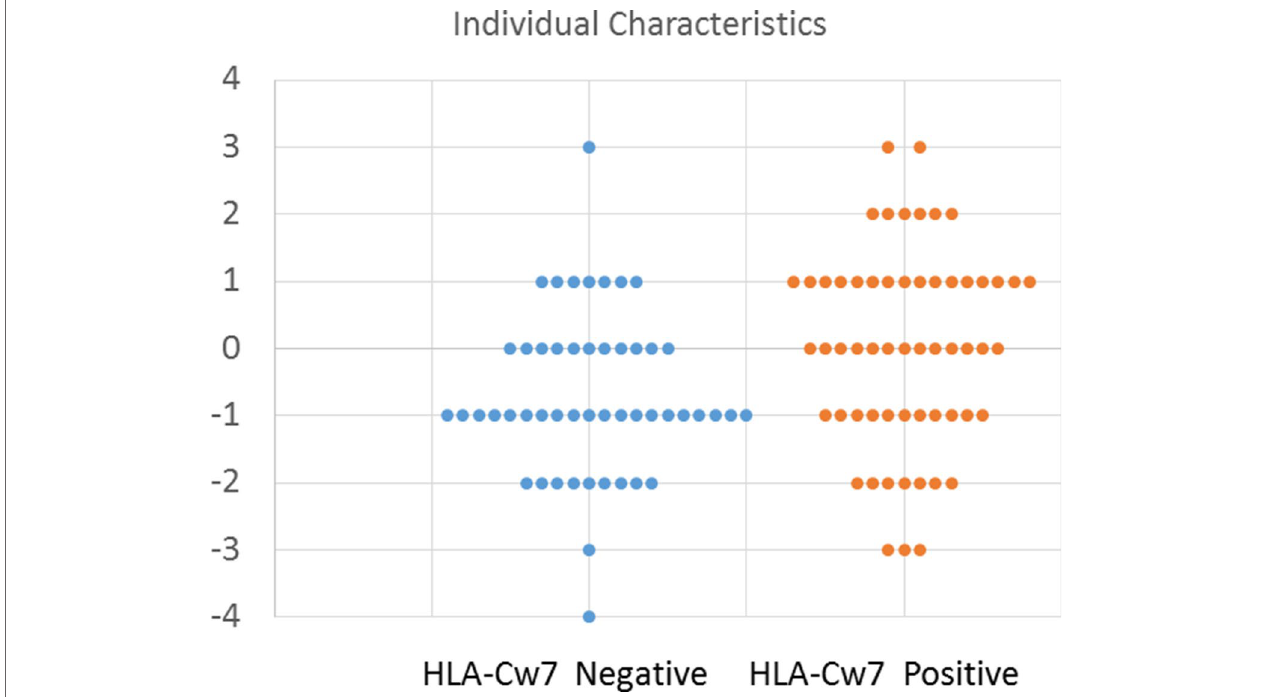
FIGURE 2 | Number of characteristics for HLA-Cw7-negative and HLA-Cw7-positive participants. Clinical characteristics that are more representative of absence of HLA-Cw7 indicate weighted negative, and clinical characteristics of presence of HLA-Cw7 indicate weighted